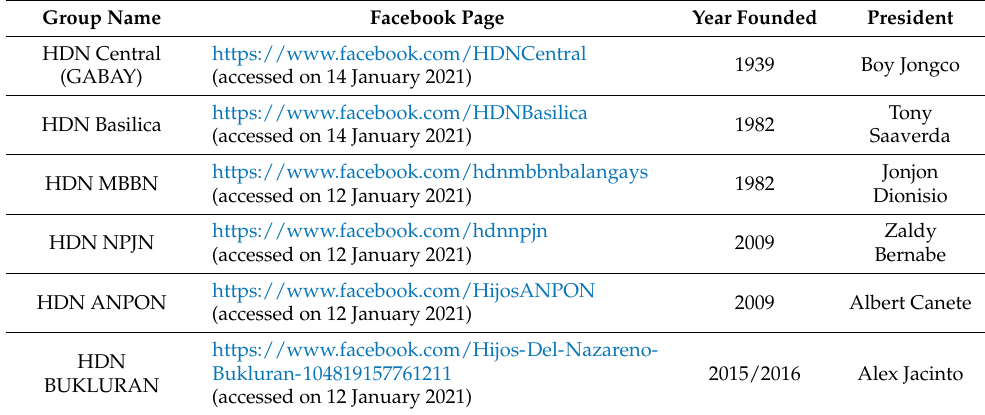
Table 2. Quiapo’s Hijos Del Nazareno